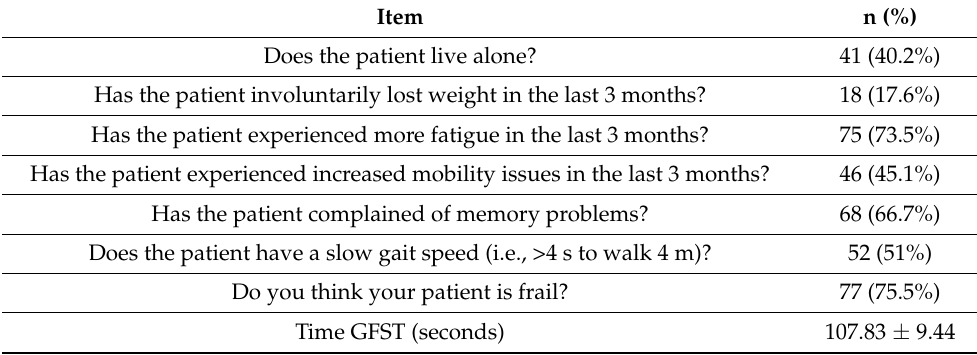
Table 5. Frailty according to Gerontopole Frailty Screening Tool (GFST) scale.